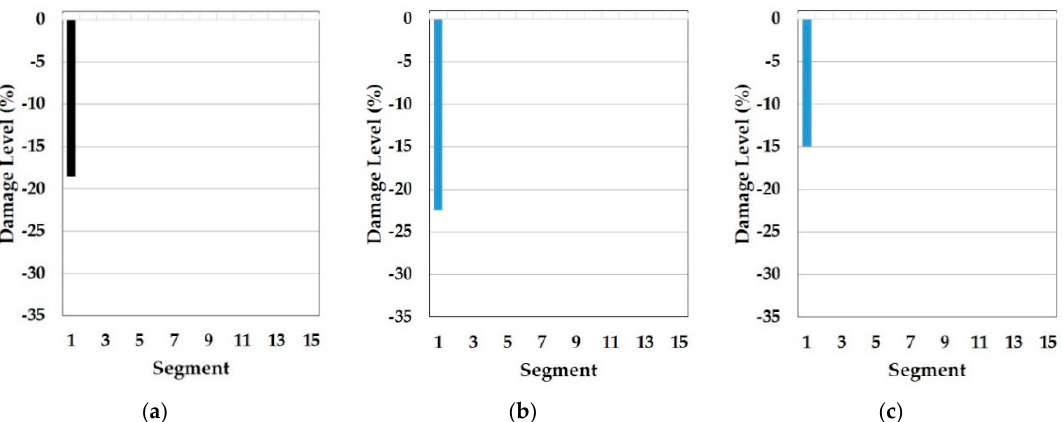
Figure 8. Symmetric baseline model under DS1 (blue color is correct segment whereas orange color is incorrect segment): ( a ) Predicted damage from the GA (black color); ( b ) top one damage case using the first to fourth natural frequencies; ( c ) top two damage case using the first to fourth natural frequencies.